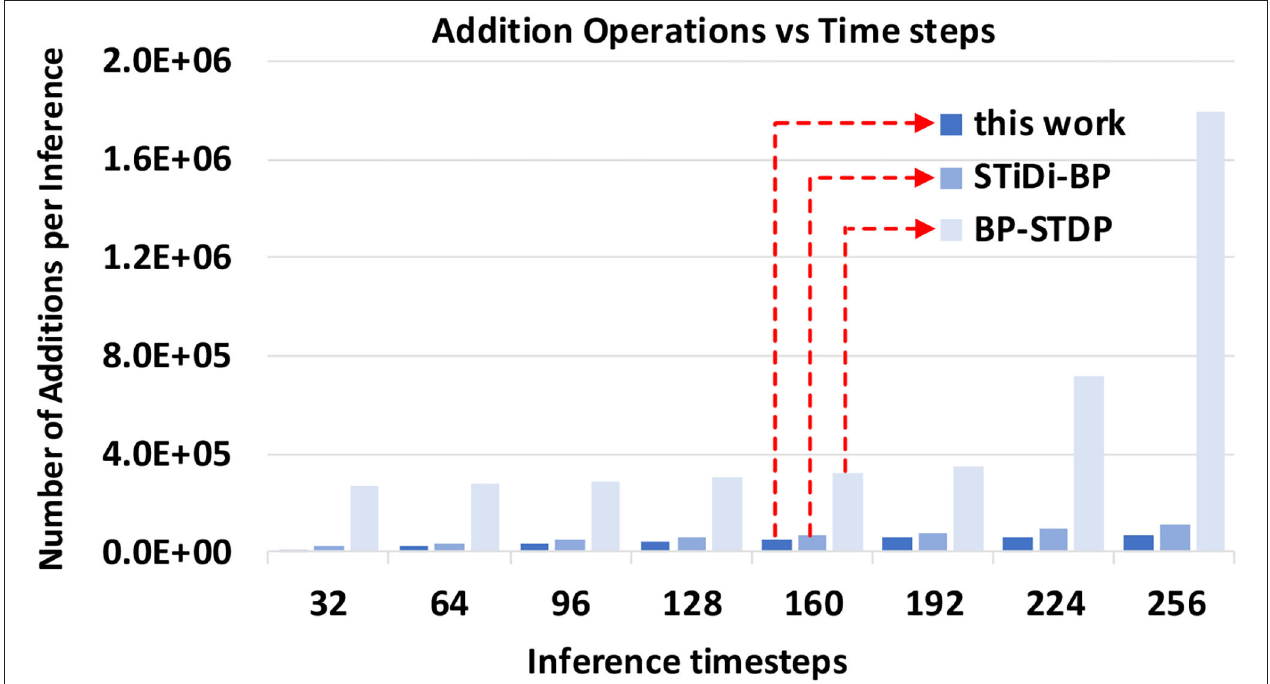
FIGURE 10 | The Inference computational cost (addition operation) evolution curve comparisons between SSTDP and the two baseline SNNs (STiDi-BP and